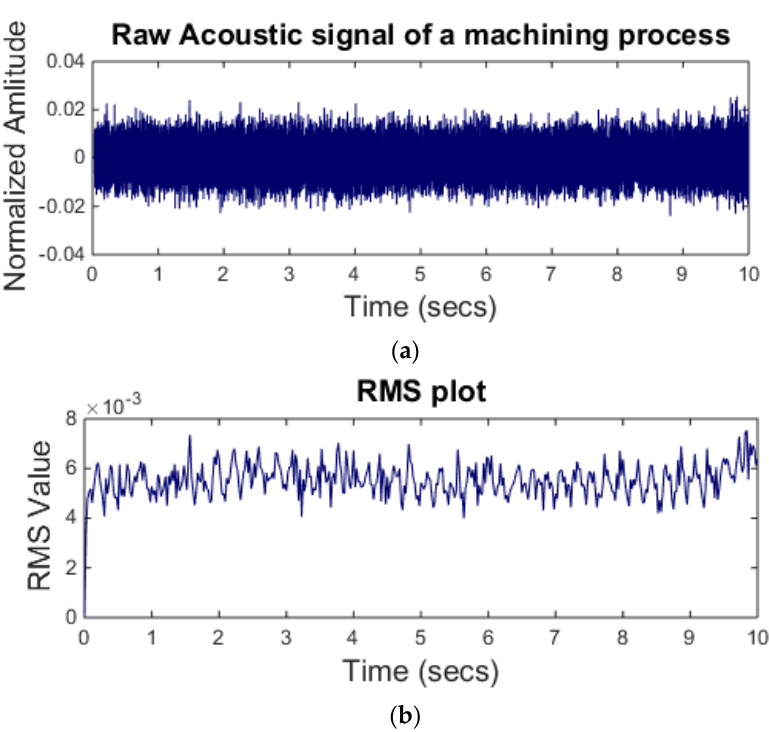
Figure 5 . ( a ) Raw acoustic signal (above); ( b ) RMS level of the signal.